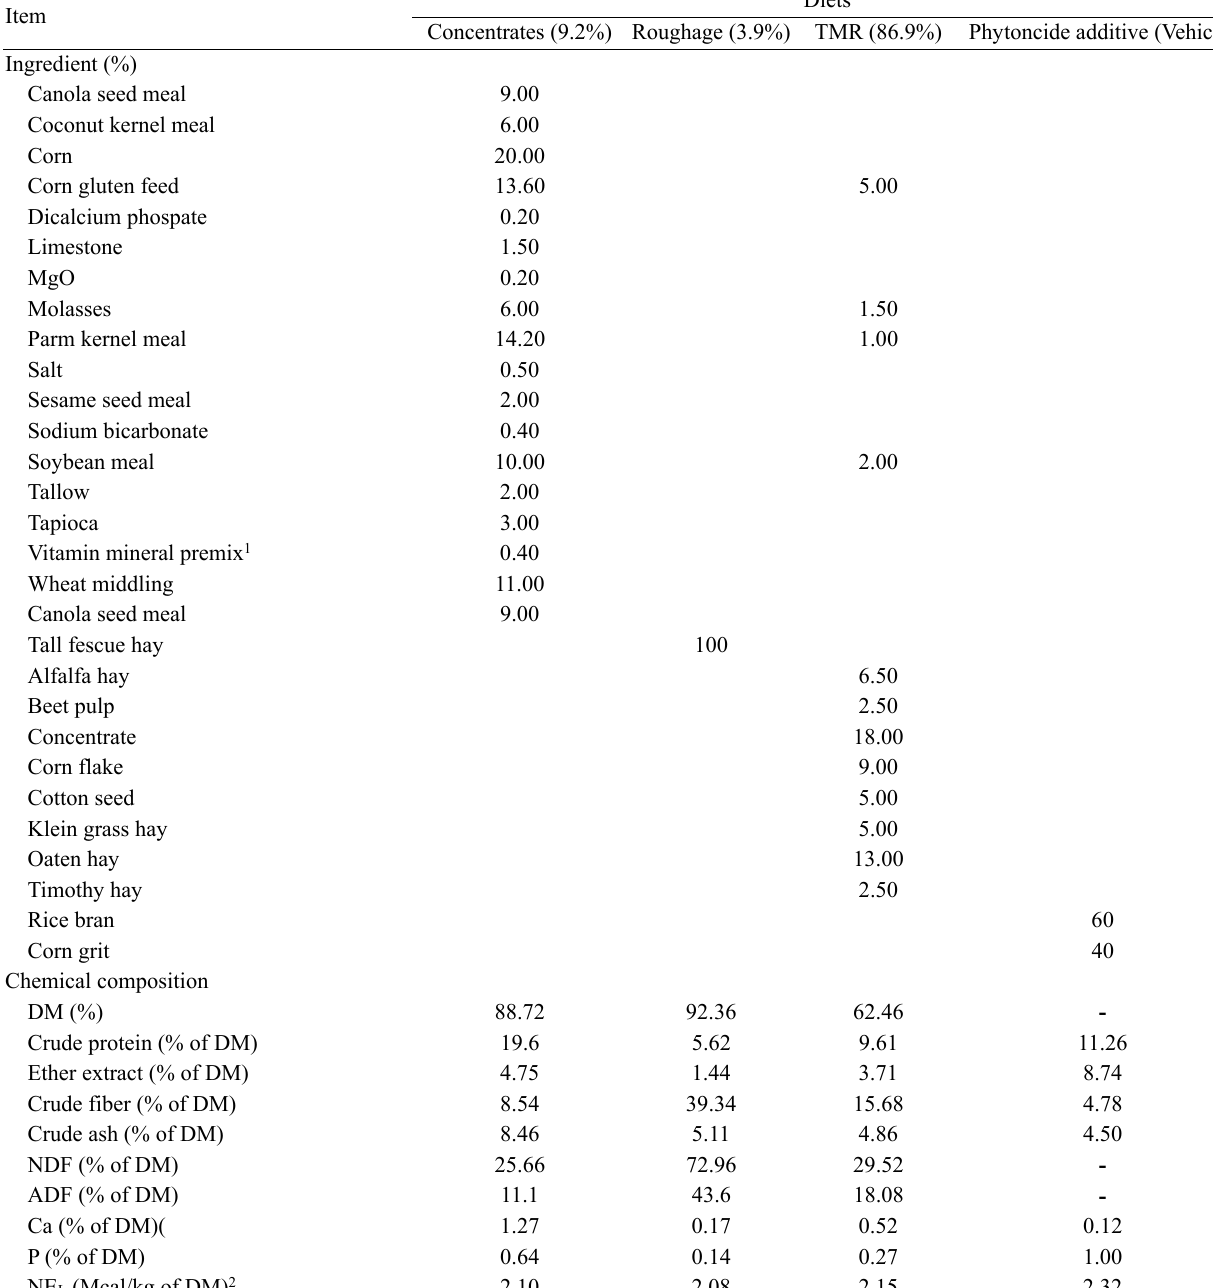
Table 1. Ingredient and chemical composition of the experimental diet Item